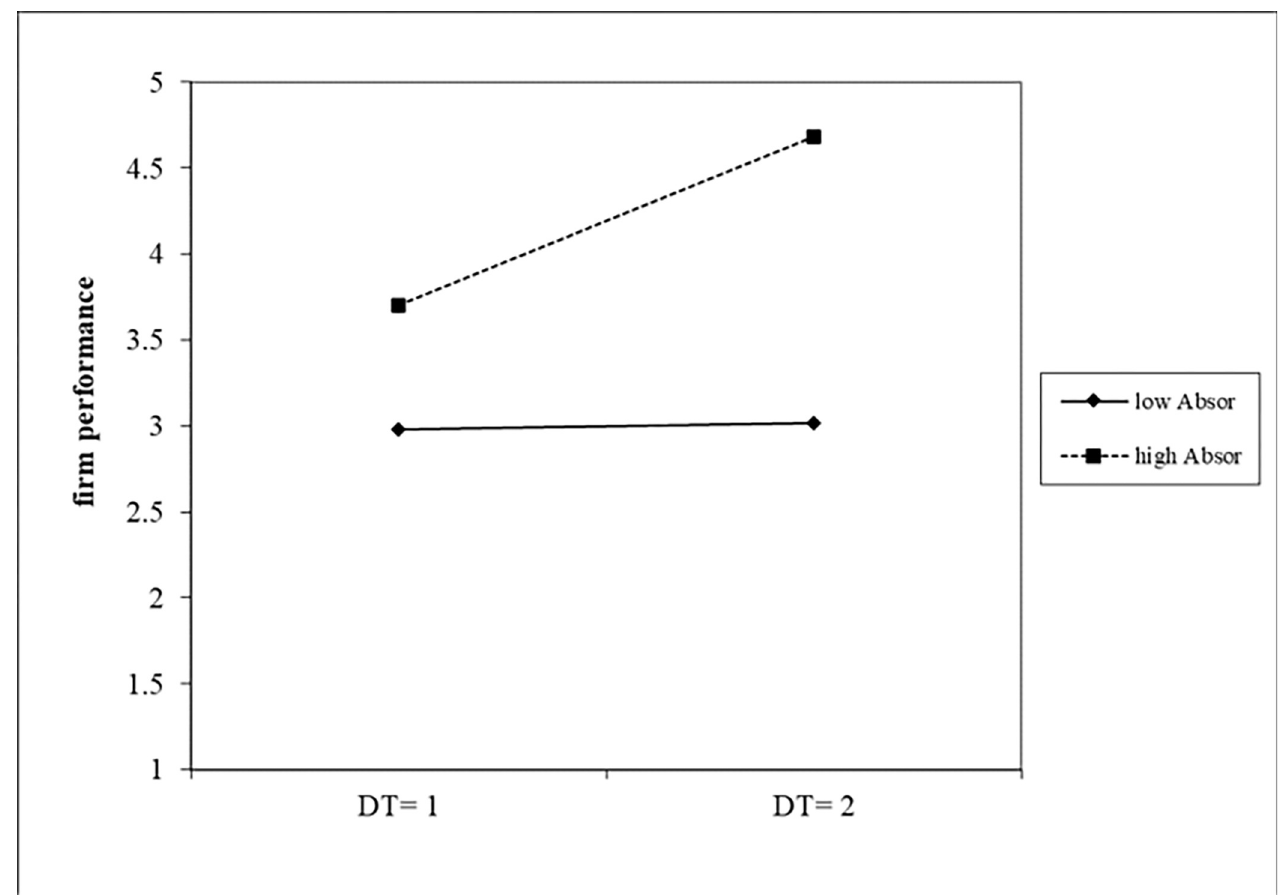
Fig 5. The moderating effect of absorptive capability on firm